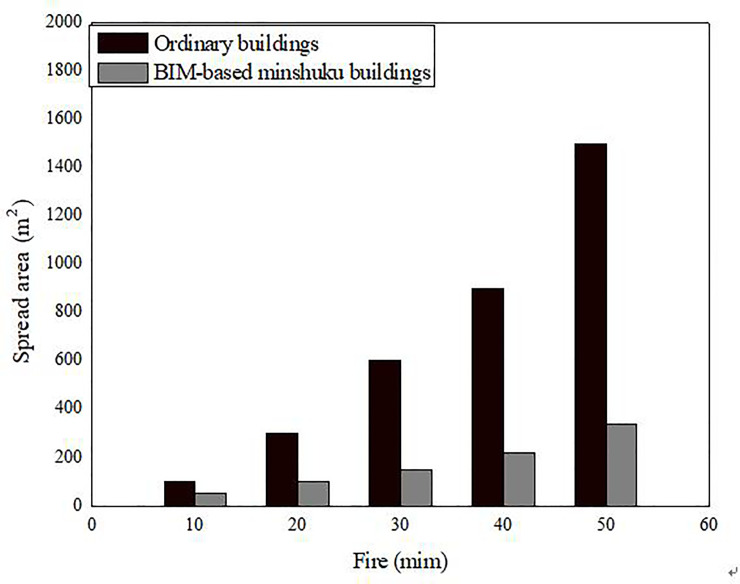
The burning area in homestay buildings based on BIM.